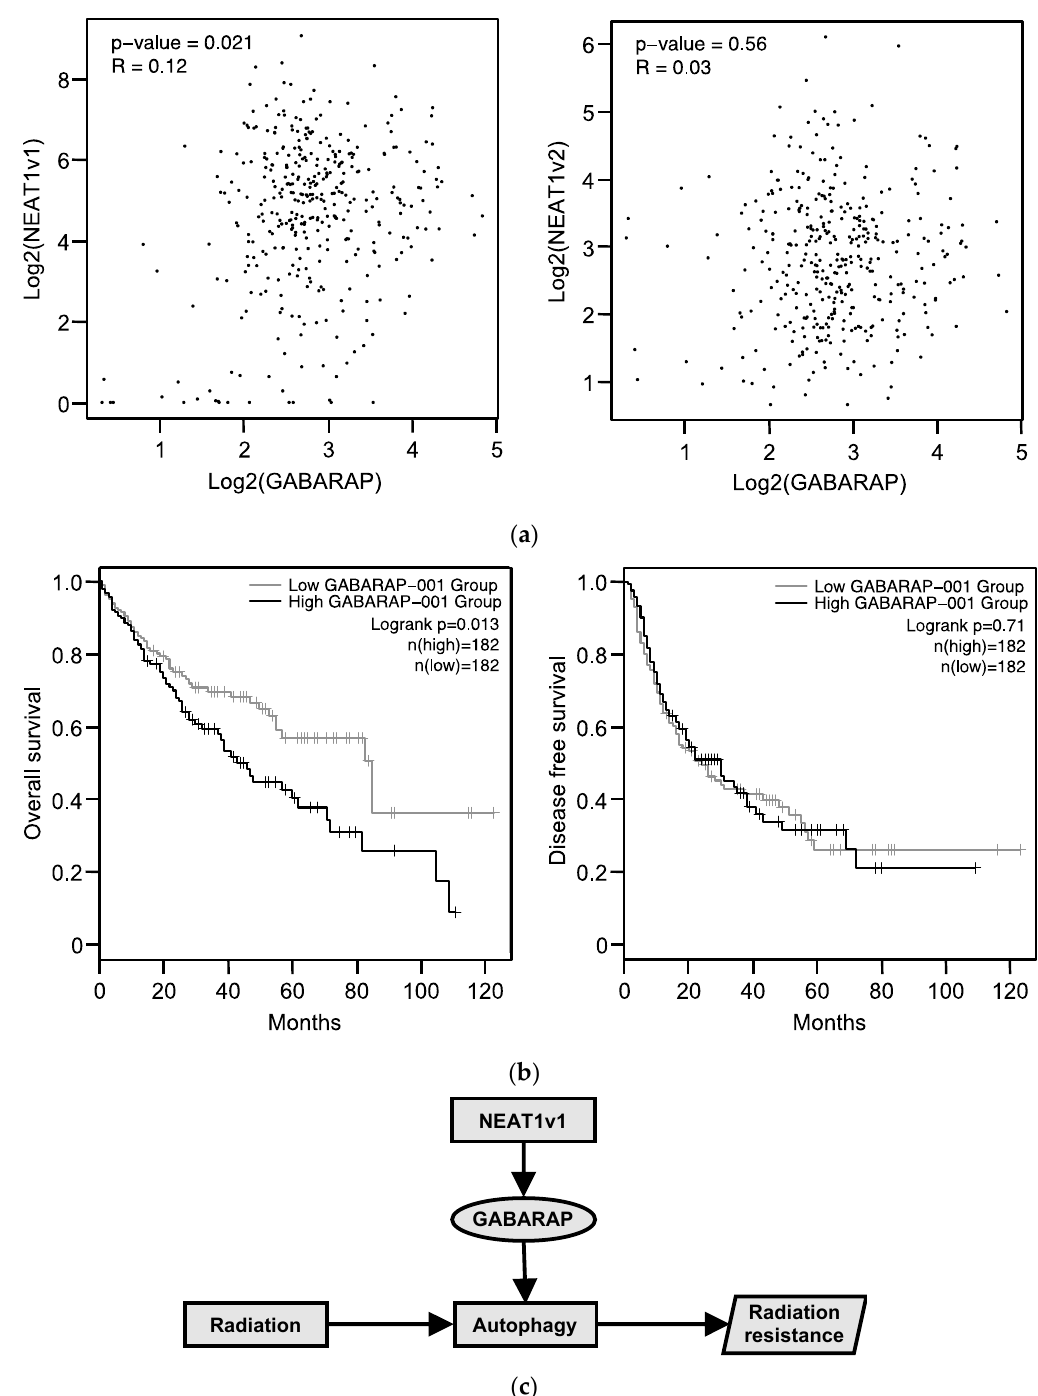
Figure 6. NEAT1 and GABARAP expression in HCC tissues of the TCGA dataset. ( a ) Spearman correlation analysis between GABARAP (ENST00000302386.9) and NEAT1v1 (ENST00000499732.2) (left) or NEAT1v2 (ENST00000501122.2) (right). ( b ) Overall and recurrence ‐ free survival of HCC patients according to GABARAP (ENST00000302386.9) expression. ( c ) Schematic representation of the mechanism underlying NEAT1v1 ‐ induced radioresistance via GABARAP.